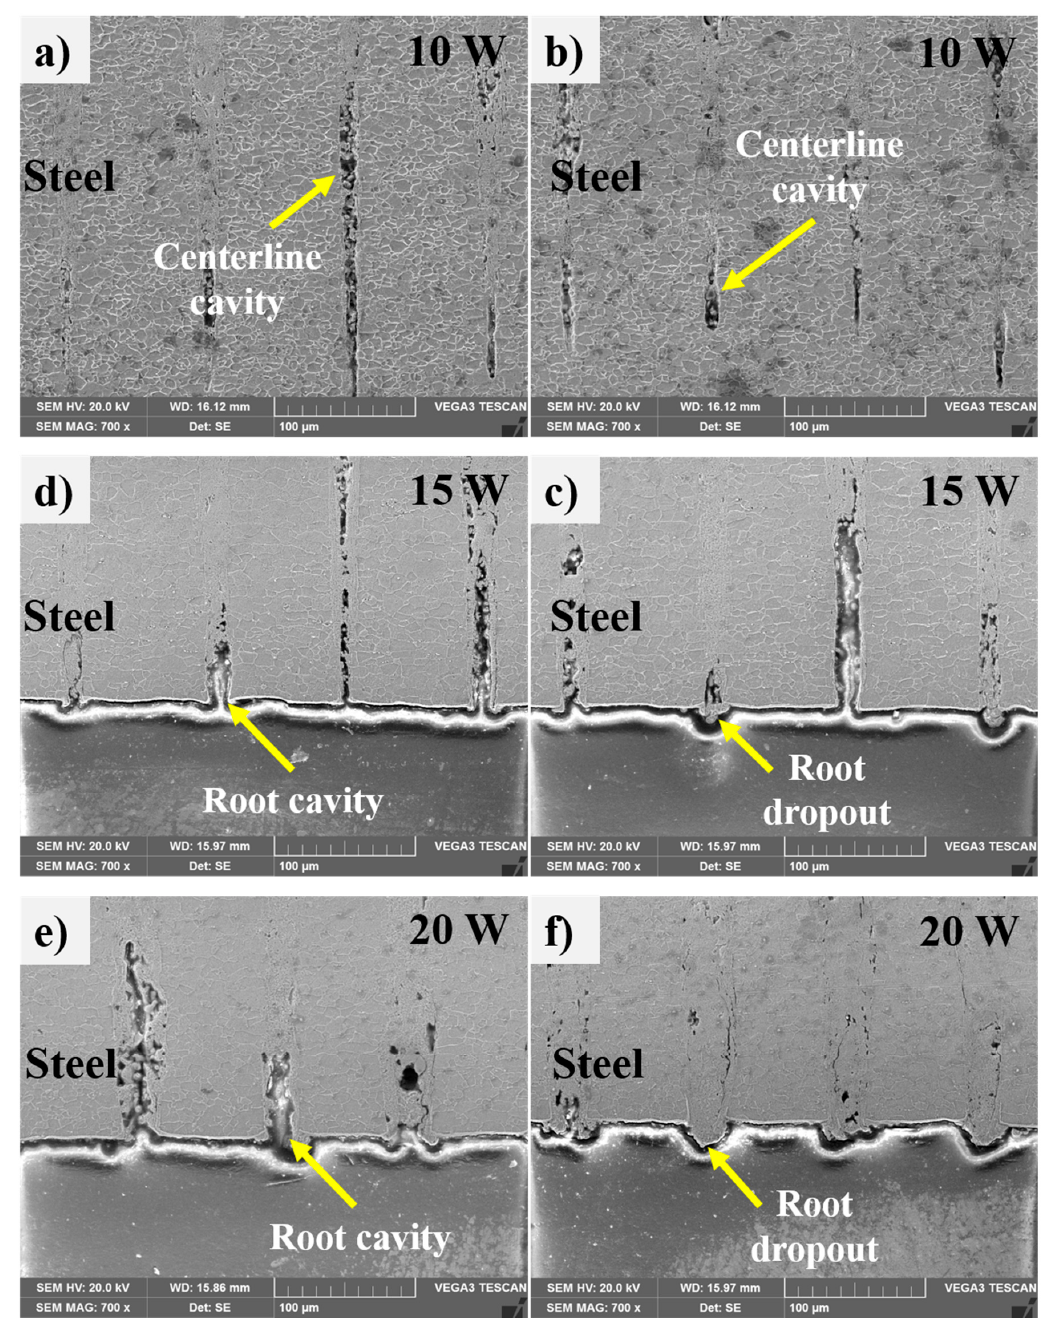
Figure 6. Centerline cavities, root cavities and root dropout, ( a , b ) laser power of 10 W, ( c , d ) laser power of 15 W, ( e , f ) laser power of 20